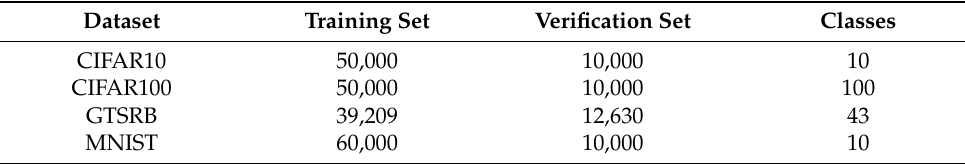
Table 1. The number of images and classes within each experimental